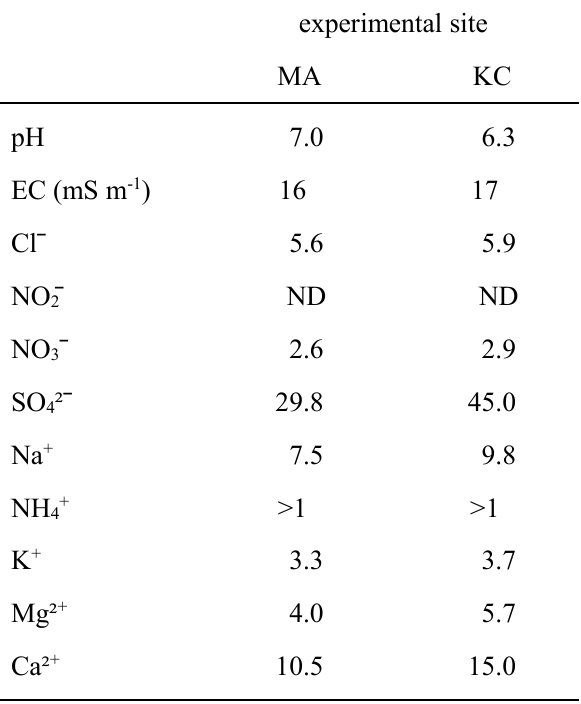
Table 1. Comparison of water quality at the mountain (MA) and urban (KC) experimental sites. ND = not detected. Units are mg L -1 unless otherwise indicated.